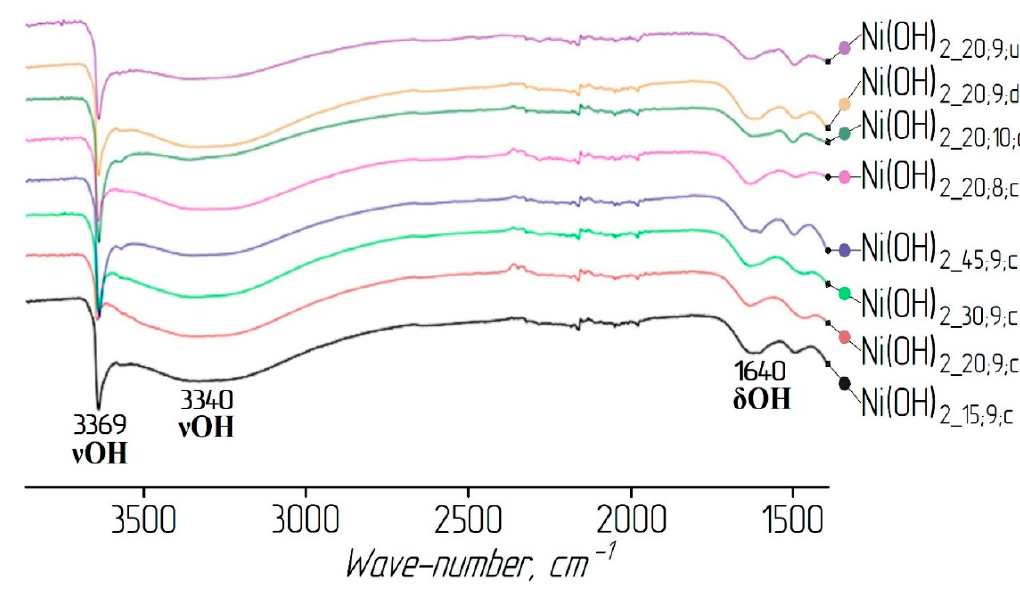
Figure 3. IR spectra of the nickel hydroxide samples.